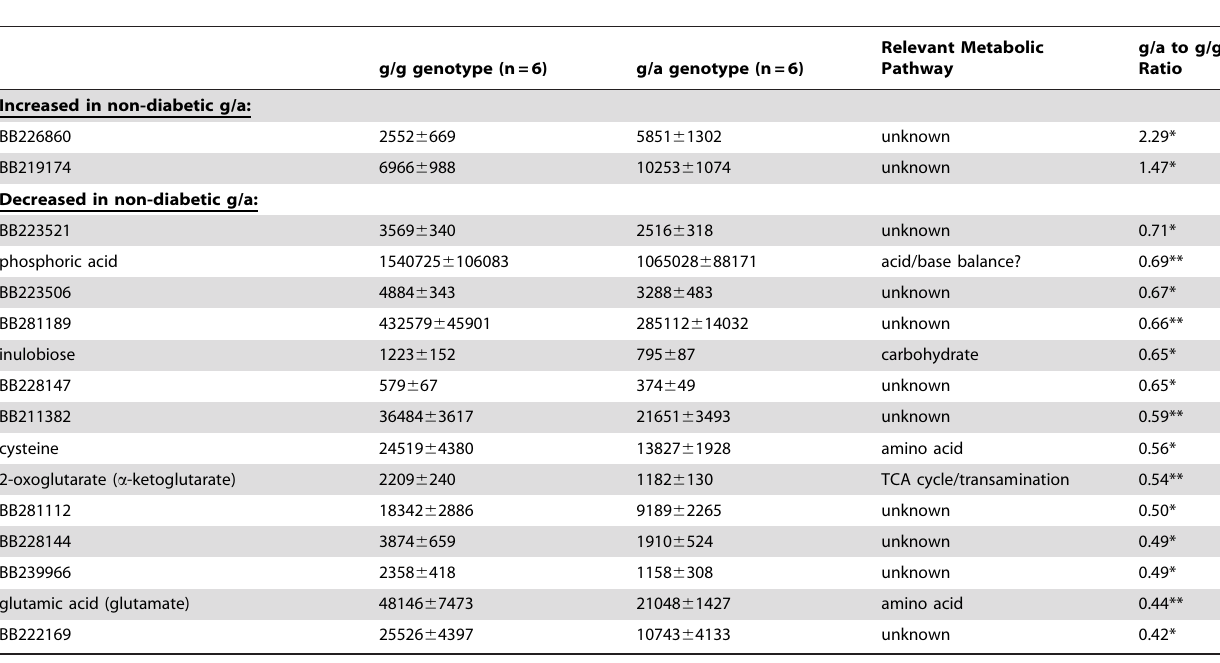
Table 1. Plasma metabolites with significantly-altered concentrations in non-diabetic obese African-American women harboring a UCP3 g/a missense